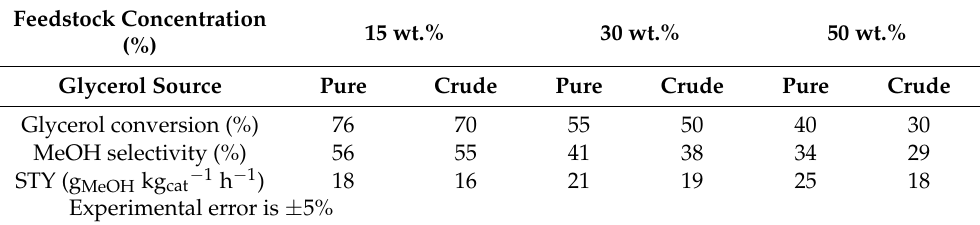
Table 1. Comparison of pure and crude glycerol over a CeO 2 catalyst. Data reproduced from ref. [39] with permission from Springer Nature. Reaction conditions: 1.0 g catalyst, 1 mL h − 1 glycerol/water flow, 100 mL min − 1 Ar, 340 ◦ C reaction temperature, 3 h reaction